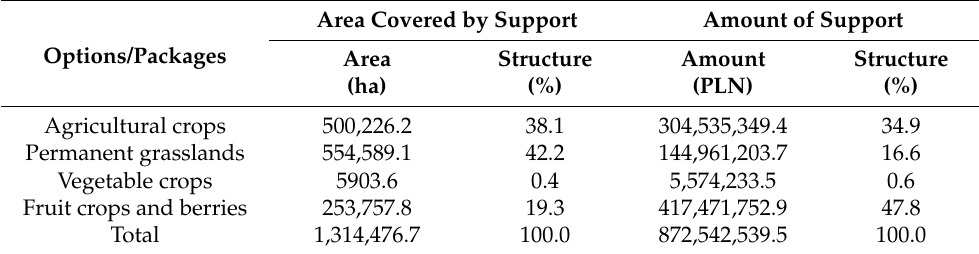
Table 2. Area under and support allocated to organic farming by option provided for in the 2004–2006